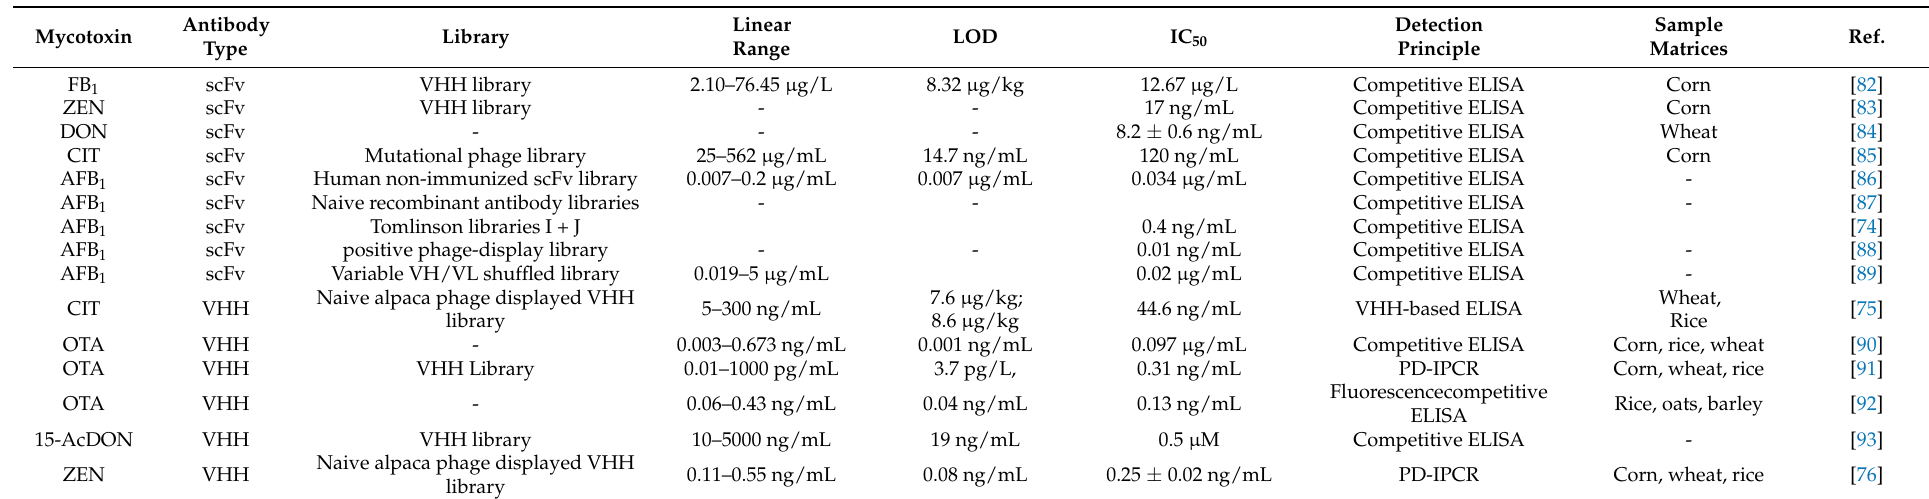
Table 2. Recombinant antibodies and their performances in immunoassay